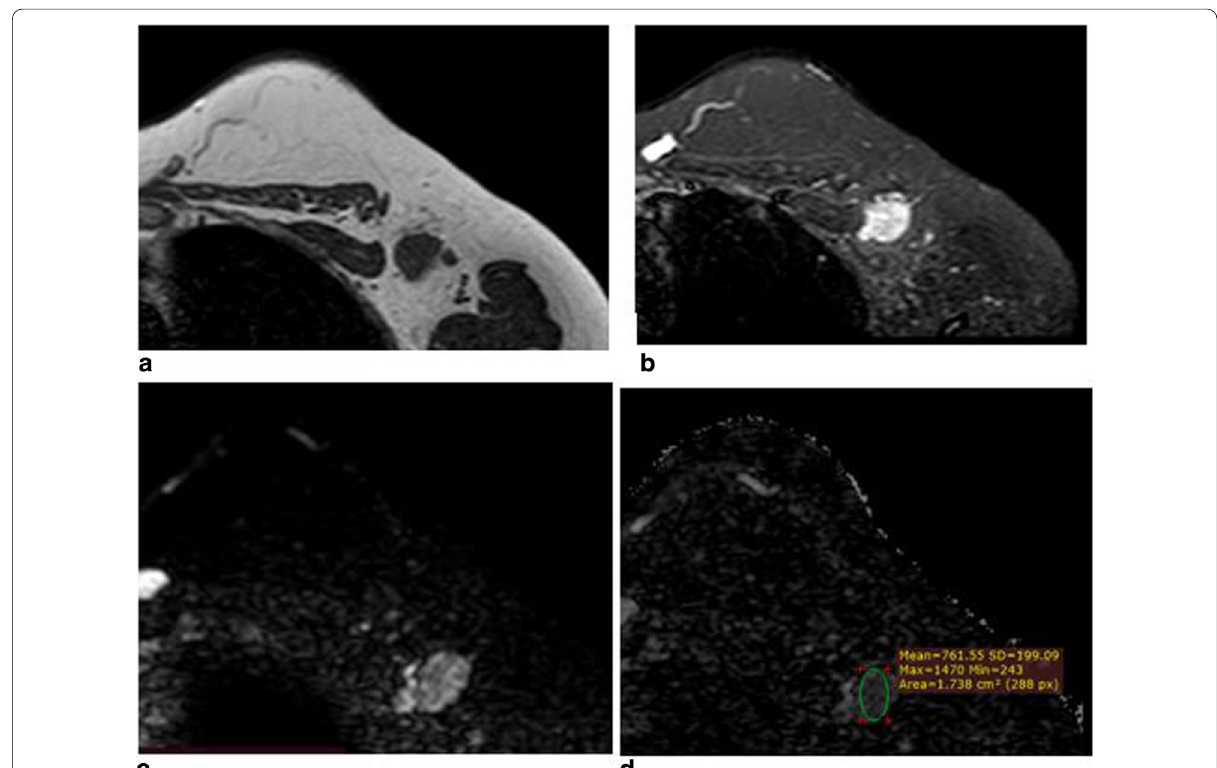
Fig. 3 A 28-year-old female a , b T1W1 and STIR enlarged left axillary lymph node with eccentric hilum and increased SI in STIR. c , d increased SI in DW-MRI and dropped SI in ADC map with ADC value (0.761